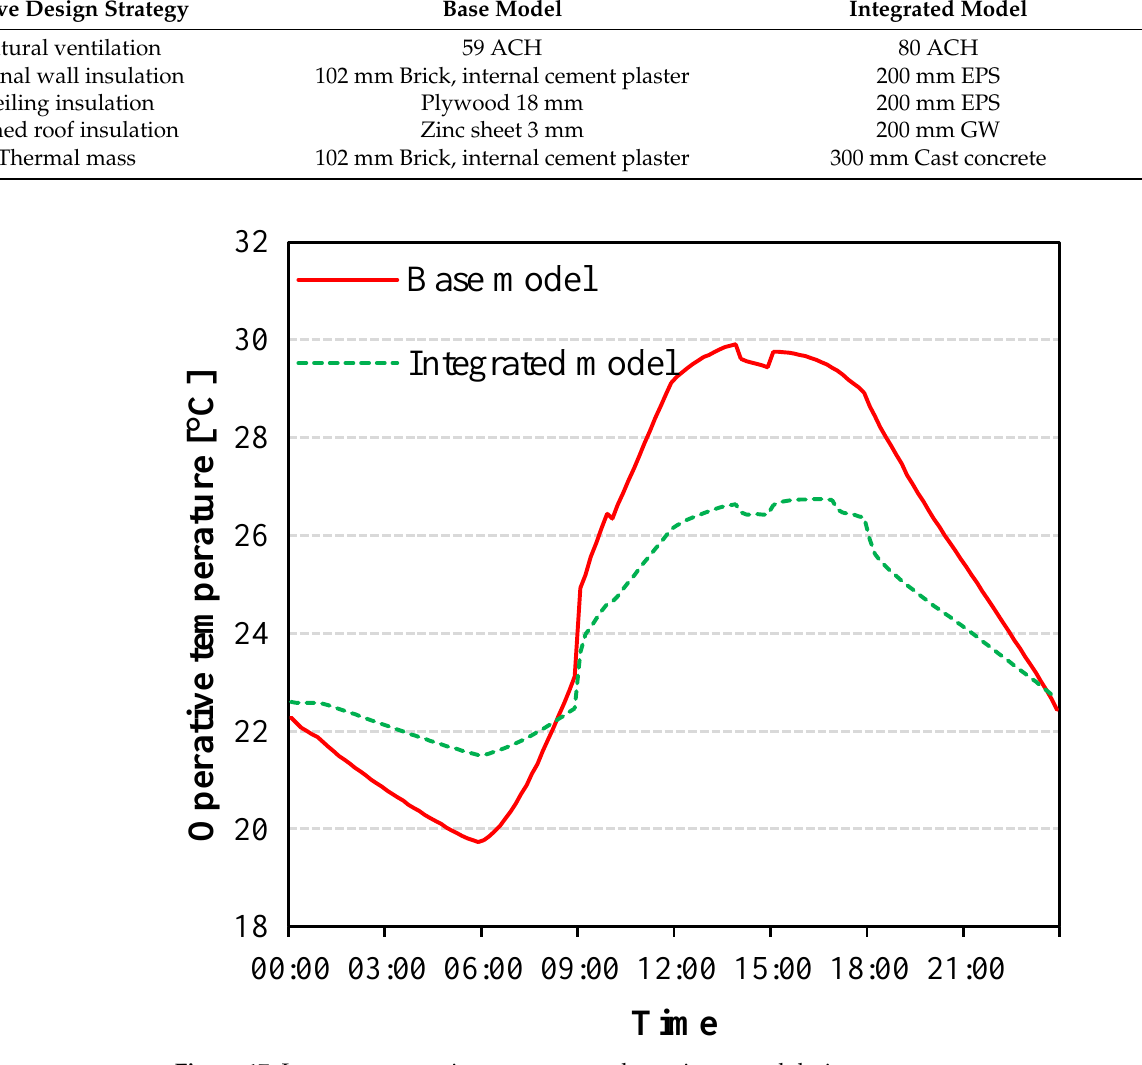
Figure 17. Impact on operative temperature due to integrated design strategy.